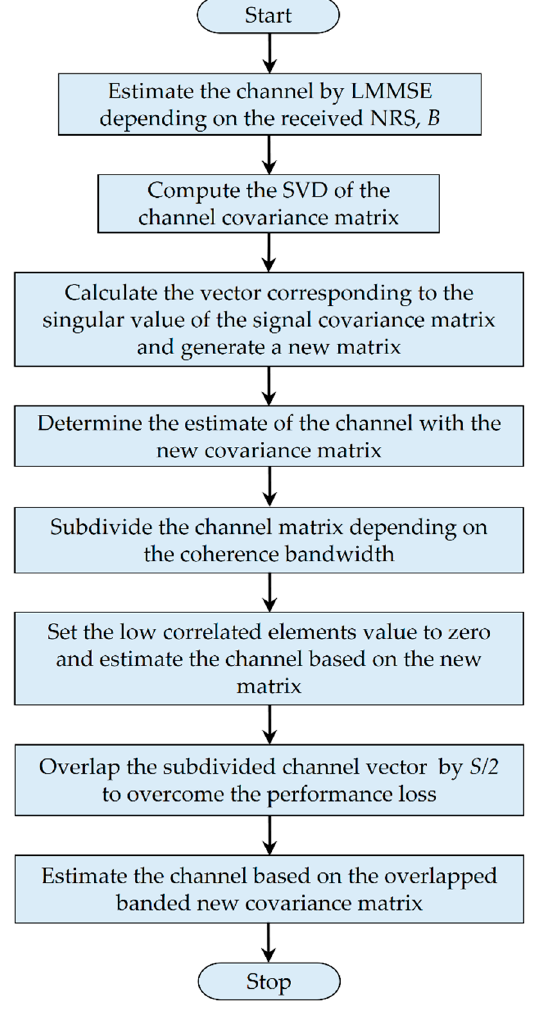
Figure 7. Proposed algorithm flowchart.